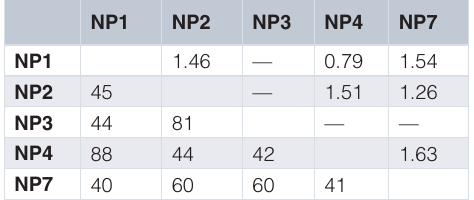
Table 2. Comparison of the RMSD values (Å; upper triangle) and amino acid sequence identities (%; lower triangle) of NP1, 2, 3, 4, and 7 a